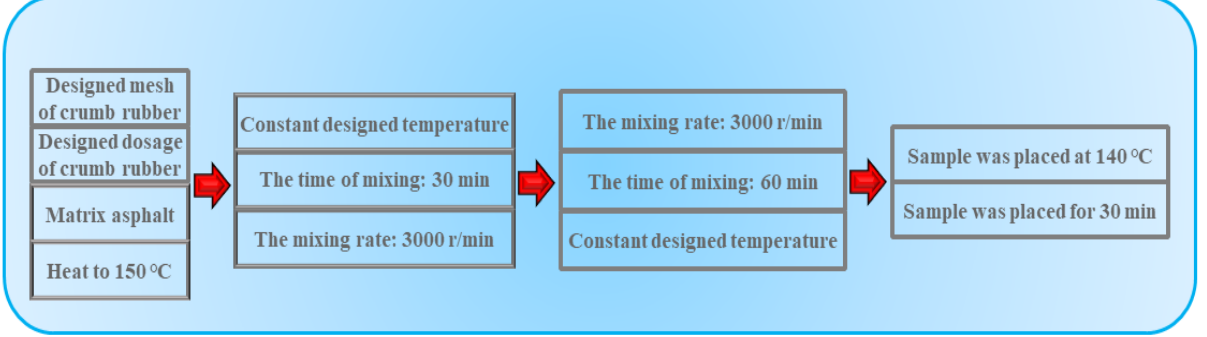
Figure 9. The preparation process of crumb rubber modified asphalt.